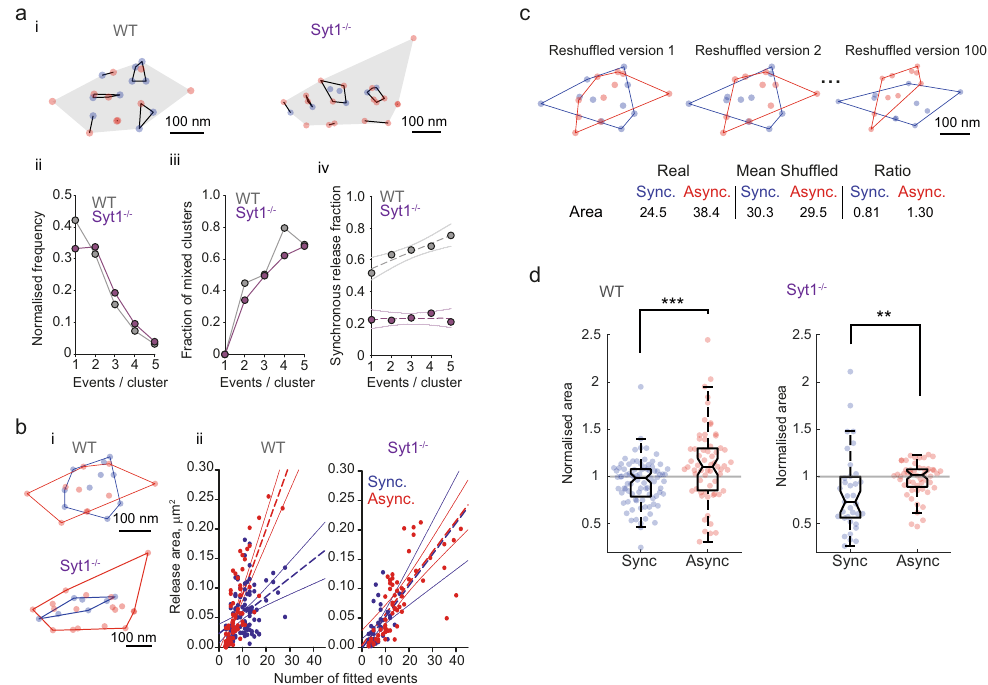
Fig. 6 Relative distribution of synchronous and asynchronous release events in the active zone. a Hierarchical cluster analysis of vesicular exocytosis sites. (i) Distributions of clustered events (clustering diameter threshold 100 nm, see Methods) in a representative wild type bouton (same as in Fig. 5a – d) and a Syt1 − / − bouton. (ii) Distributions of number of events per cluster. (iii) Dependences of mixed clusters fraction (containing both synchronous and asynchronous events) on the number of events per cluster. (iv) Increase of synchronous events fraction with cluster size in wild type synapses. Dashed lines, linear regression. Solid lines 95% con fi dence intervals. (ii) – (iv) pooled data from m = 799 clusters from n = 106 boutons in wild type and m = 553 clusters from n = 64 boutons in Syt1 − / − neurons. b Comparison of convex hull areas circumventing synchronous or asynchronous events. (i) Representative boutons (the same as shown in a ). (ii) Relationship between the release areas and the number of fi tted events in all analysed boutons. Dashed lines, linear regression. Solid lines, 95% con fi dence intervals. c Illustration of the reshuf fl ing analysis used to compare spatial distributions of synchronous and asynchronous events within individual synapses (representative reshuf fl ed versions of the wild type bouton shown in ( a ), see text for details). d Comparison of the normalised areas for synchronous and asynchronous events in wild type and Syt1 − / − synapses. Data points and box-and- whisker plots: centre, median; notch 95% con fi dence interval for median; box, 25th – 75th percentiles; whiskers, the most extreme data points not considered outliers (within 1.5 times the interquartile range from the bottom or the top of the box). ** p < 0.01, *** p < 0.001, two-tailed Mann – Whitney U test (for exact p values see SourceData.xlsx fi